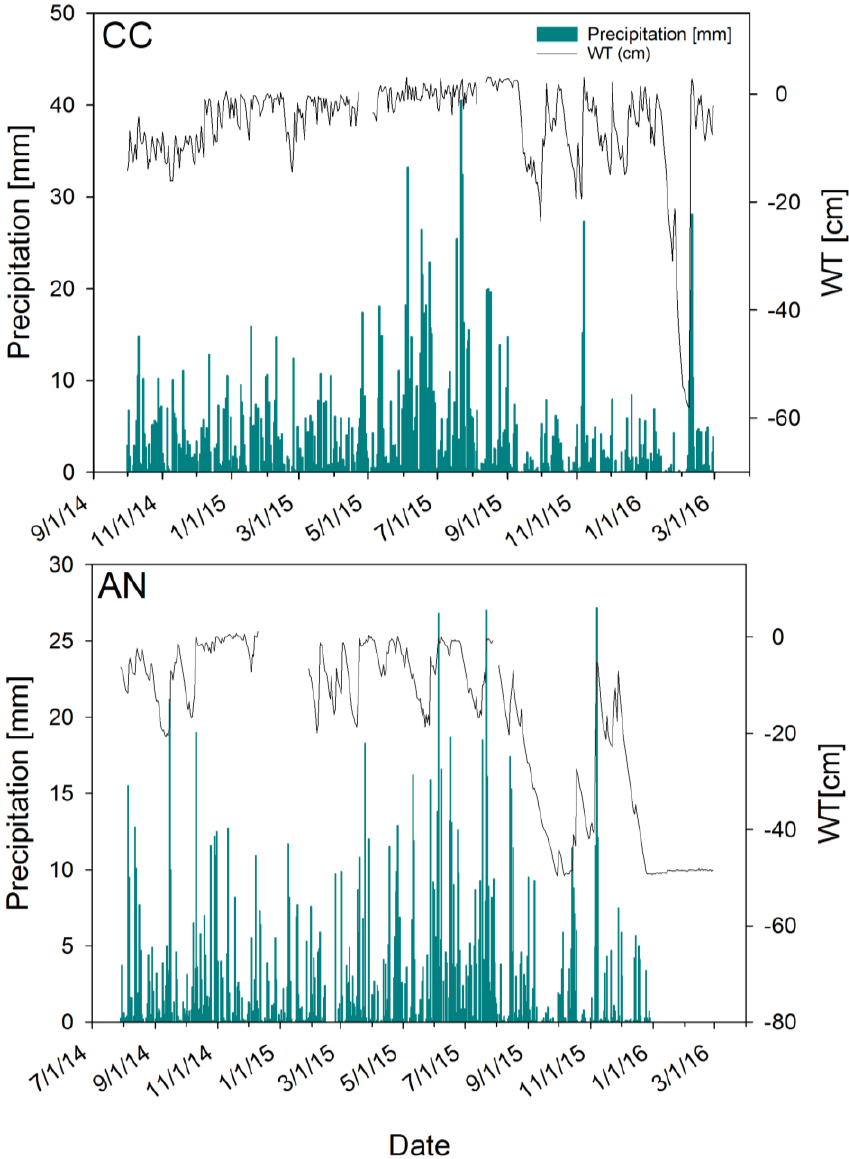
Figure 3. Water table levels (cm) for Cayambe Coca (CC) and Antisana (AN). Negative values indicate water level below the peatland surface. No precipitation data were available for AN in 2016, but the steady line for water table level suggests a long period of reduced